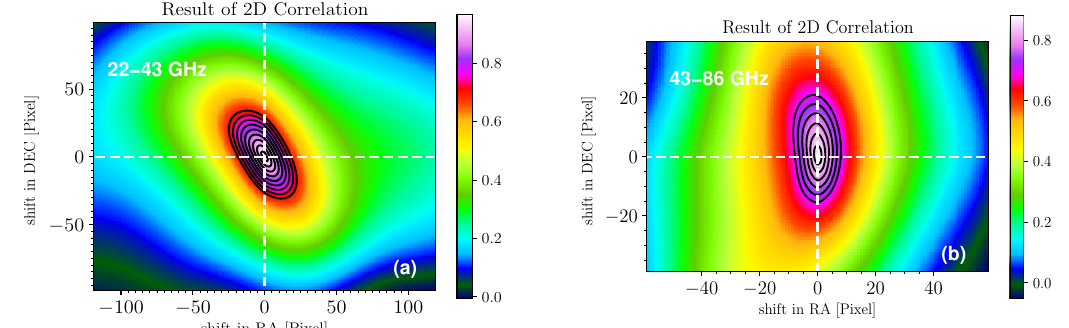
Figure 6. Panel ( a ) shows 2D cross-correlation of the optically thin regions of 22 and 43 GHz images. Panel ( b ) 2D cross-correlation of the optically thin regions of 43 and 86 GHz